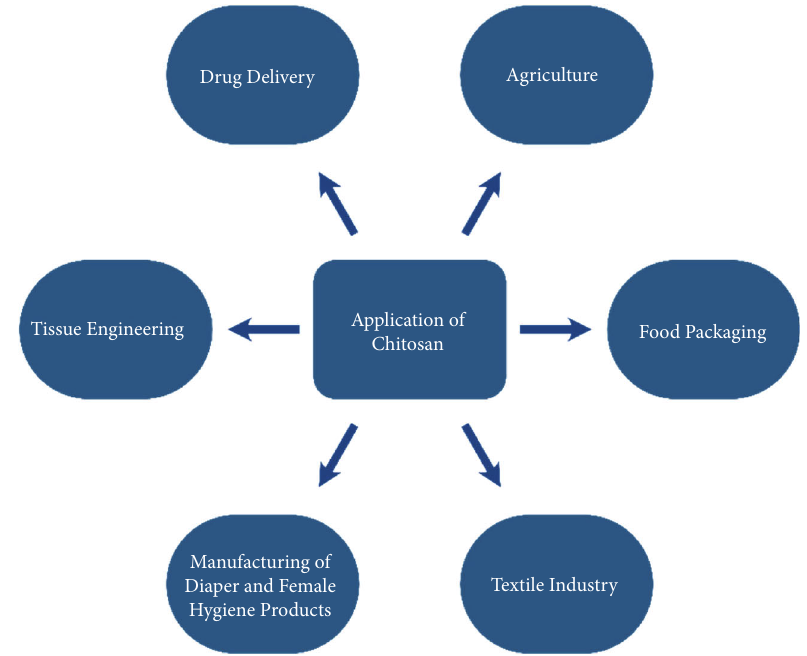
Figure 2: Applications of